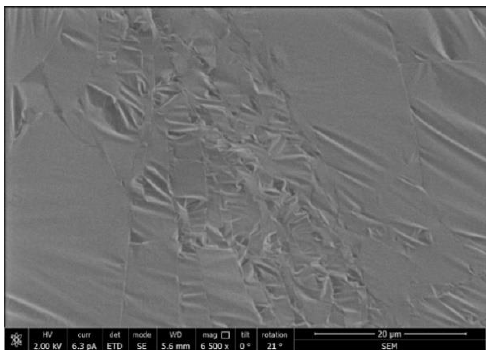
Figure 7. SEM result of nano-CaCO 3 -modified asphalt (magnification: 1000×).